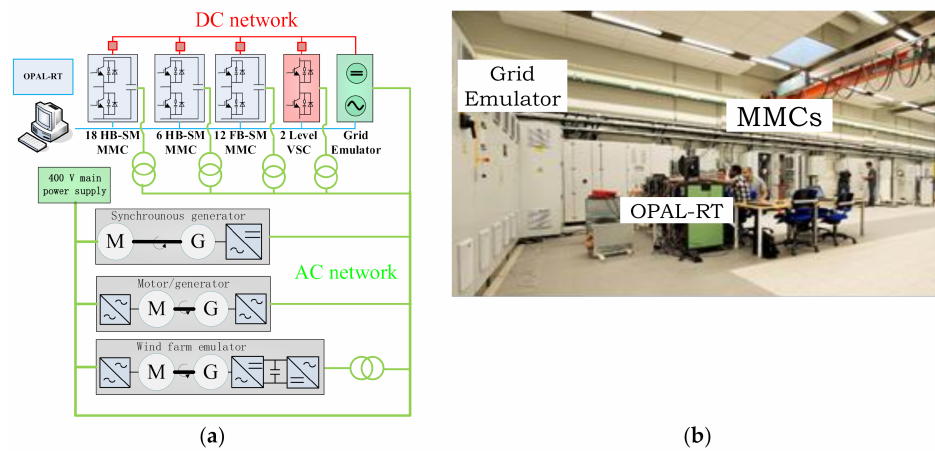
Figure 6. The experimental demonstrator. ( a ) Schematic diagram. ( b ) Configuration.